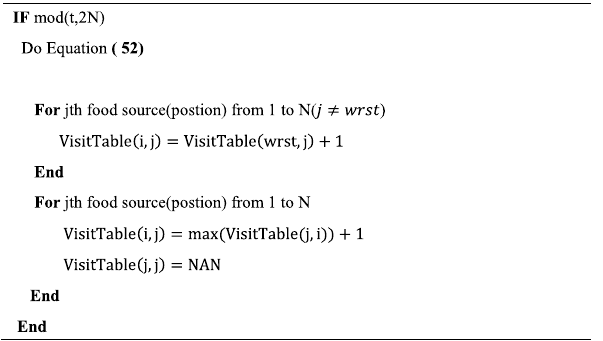
Algorithm 3. Migration forging for